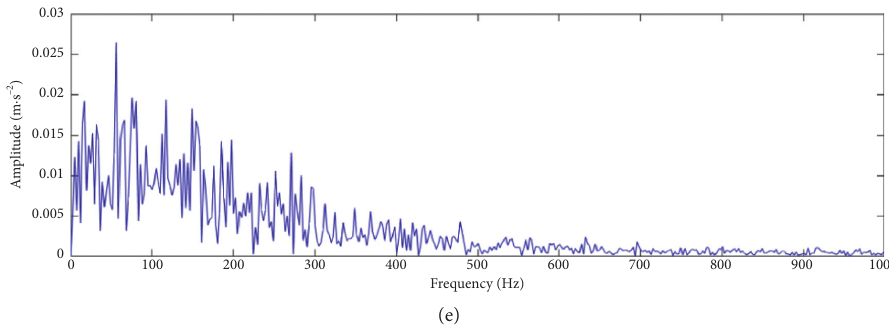
Figure 5: Analysis results of simulation signal. (a) The modes obtained by the improved VMD method. (b) WAFM indexes of IMF components. (c) Envelope spectrum of IMF4 component. (d) Envelope spectrum of IMF3 component. (e) Envelope spectrum of IMF5 component.